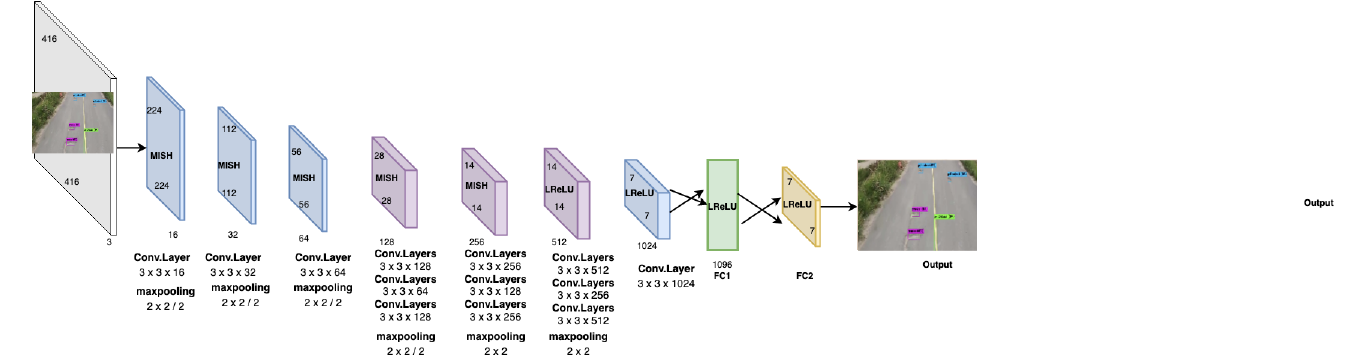
Figure 5. Architecture of the proposed deep CNN for yellow lane, cracks, and potholes detection.